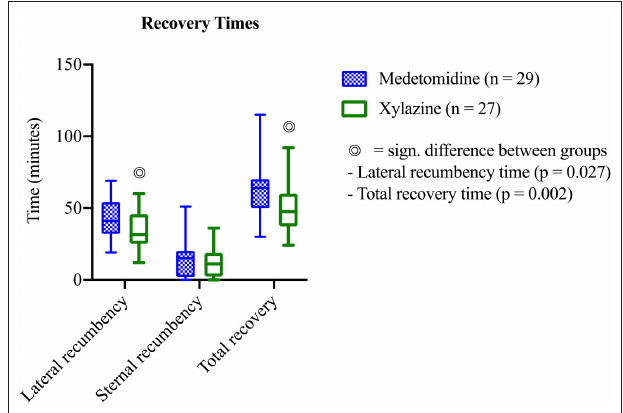
FIGURE 2 | Recovery time in horses after medetomidine isoflurane (group MED) or xylazine isoflurane (group XYL) balanced anesthesia (mean ± SEM). Significant differences between groups is marked with a double circle (